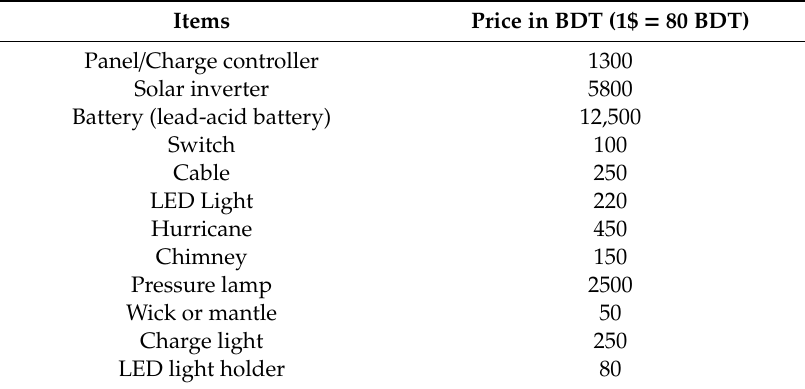
Table 4. Average replacement cost for the